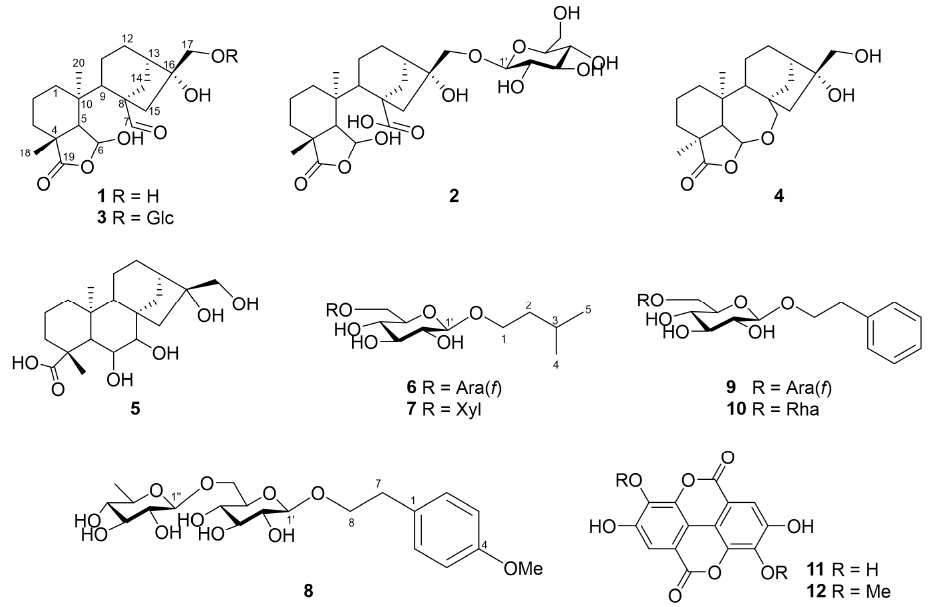
Figure 1. Chemical structures of compounds 1 – 12 .